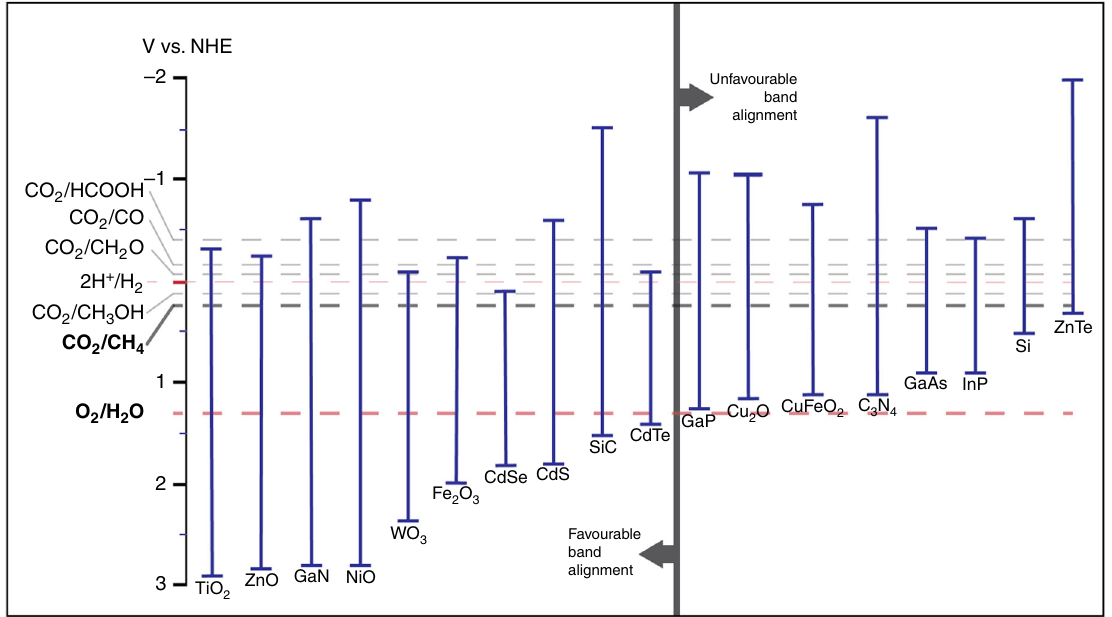
Fig. 5 Band energy diagram of selected semiconductors. These materials are commonly used for photoelectrochemical water splitting and CO 2 reduction. Redox potentials of key CO 2 reduction reactions are also included. In principle, water splitting and CO 2 reduction can take place on the same semiconductor material if the conduction band energy level is aligned with, or more negative than, the energy level of the targeted CO 2 methanation reaction ( − 0.24 V NHE ) and the valence band energy level is aligned with, or more positive than, the oxygen evolution reaction energy level (1.23 V NHE ). This is indicated by the position of each material relative to the vertical bar dividing the fi gure. The materials exhibiting unfavorable band alignment are included in the fi gure, as they are commonly used as light-absorbers in photoelectrochemical cells 66,98 — adapted from ref. 66 — Published by Wiley-VCH; and ref. 98 — Published by The Royal Society of